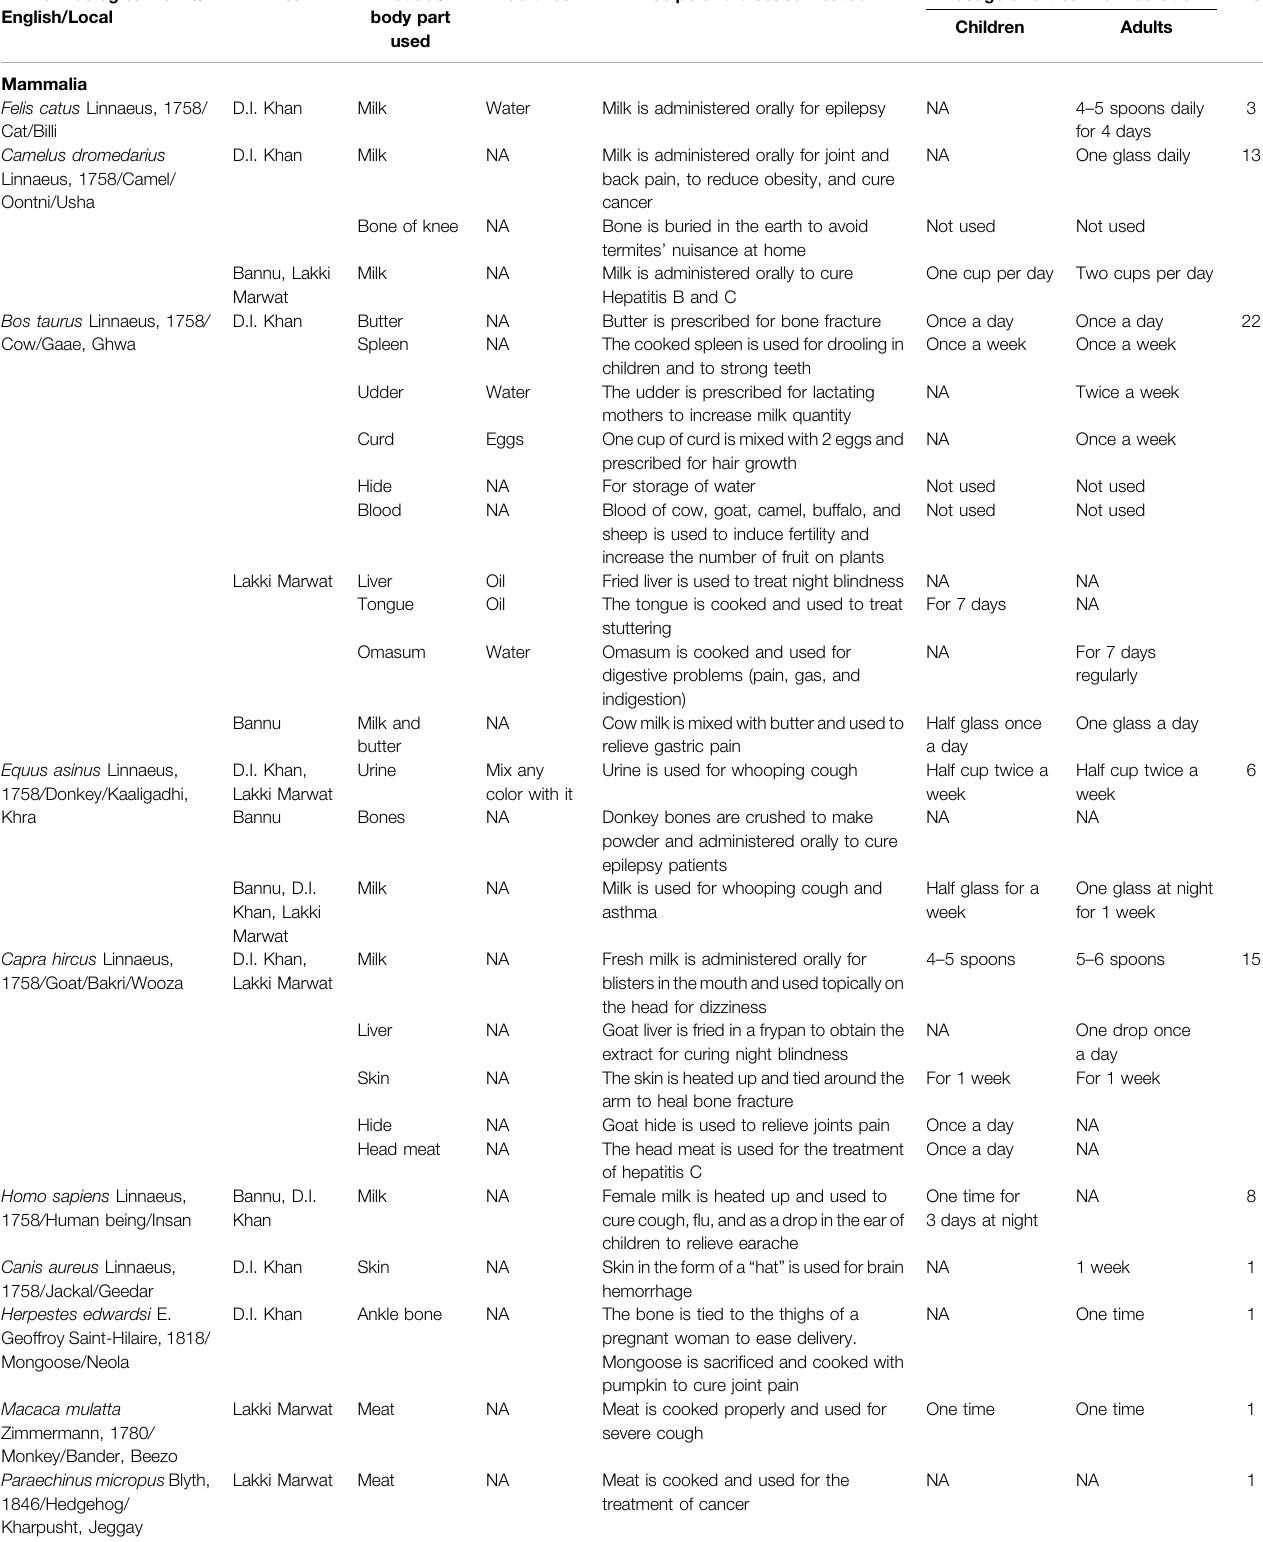
TABLE 2 | Medicinal uses of animal species and their body parts/products in southern regions of Khyber Pakhtunkhwa (Pakistan). Animal zoological name/